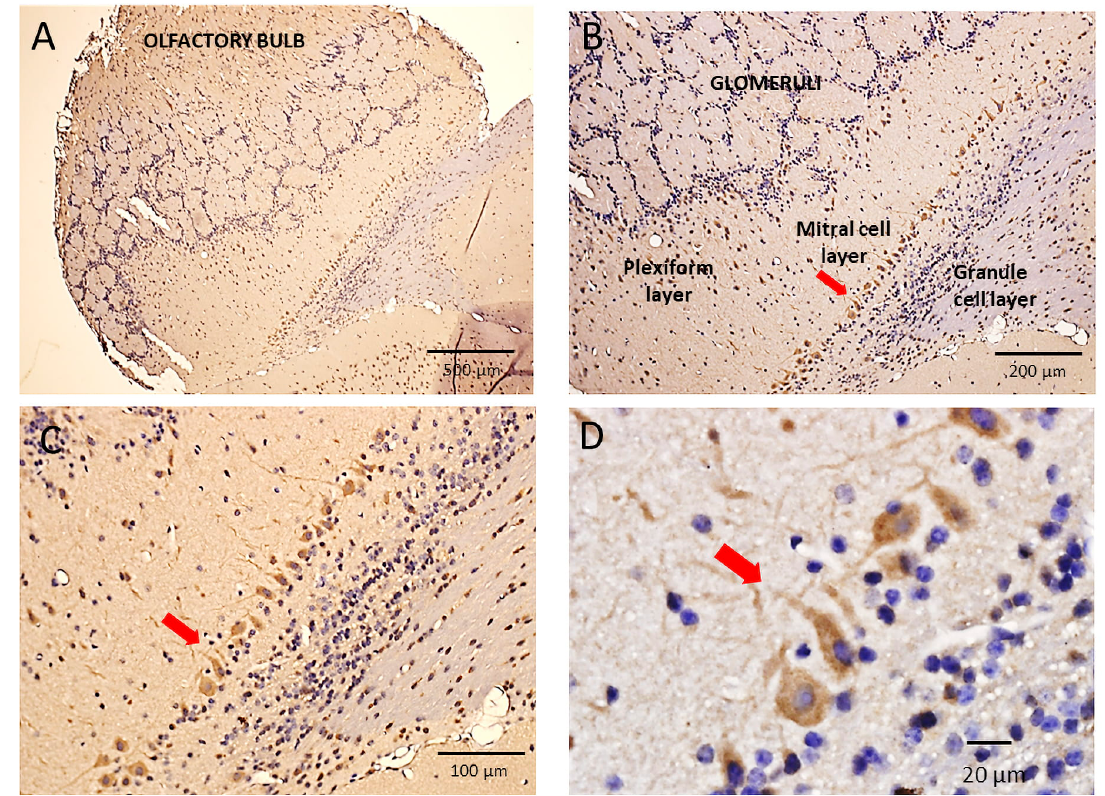
Fig. 6. Immunohistochemical localization of Piezo2 in the mouse olfactory bulb. (A) Shows a low magnification image of the mouse olfactory bulb (OB)withitscharacteristiccircular/sphericalglomerulistructuresspanningtheOB.Theseglomeruliincludethesynapticconnectionsformedbetweenprimary olfactory nerve (PON) axons and mitral cell dendrites. (B–C) Higher magnification images (10 × and 20 × objectives) of the same slice showing the uniformly stained layer of mitral cell bodies (red arrows) that separate the external plexiform layer from the internal plexiform and granule cell layers. The mitral cells represent the primary projection neuron of the OB and project their axons to the piriform and entorhinal cortices and the amygdala. The external plexiform layer includes the primary and lateral dendrites of the mitral cells that extend into and throughout the plexiform layer to reach the glomeruli. Also within this layer are the cell bodies and dendrites of the tufted cells, which did not appear stained. (D) A still higher magnified image (60 × objective) showing the morphology and staining of the mitral cells bodies and dendrites and the absence of staining of granule cells and the tufted cells in the granule cell and external plexiform layers,